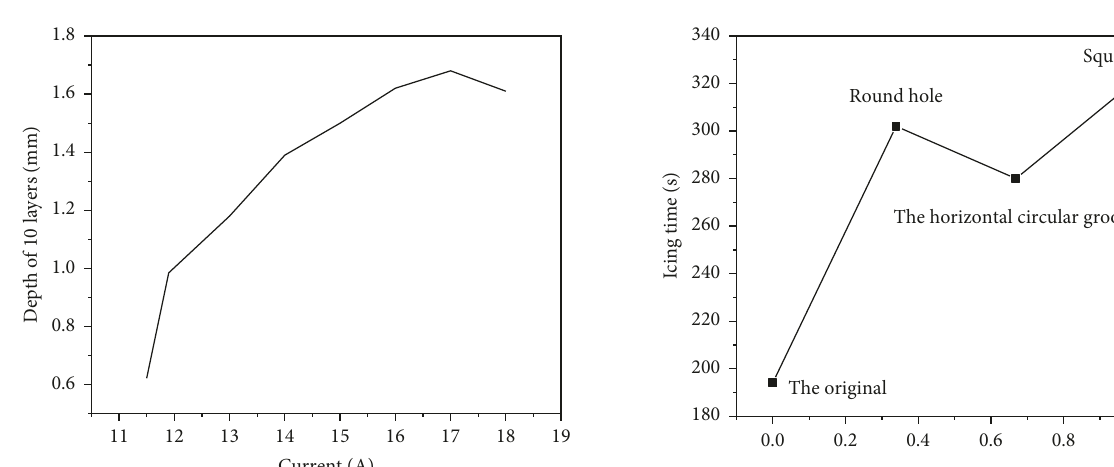
Figure 5: Comparison of average freezing time on textured surface.